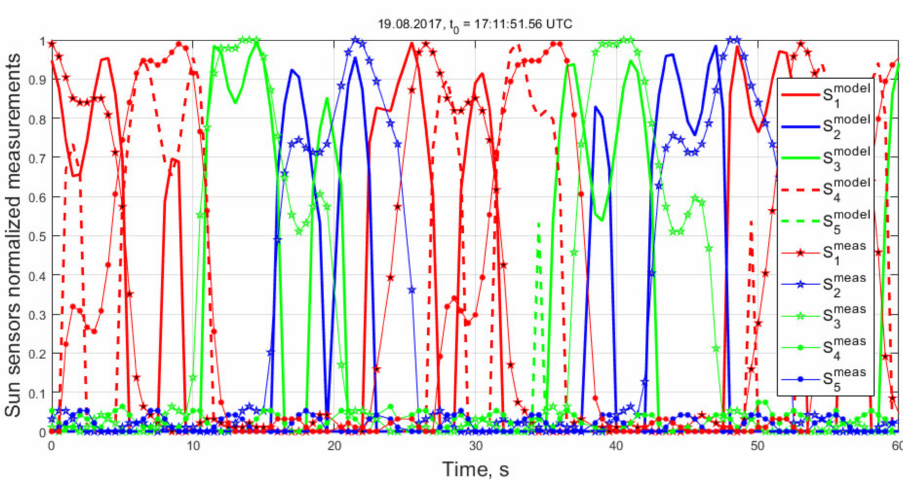
Figure 7. Sun sensors normalized measurements and its predicted